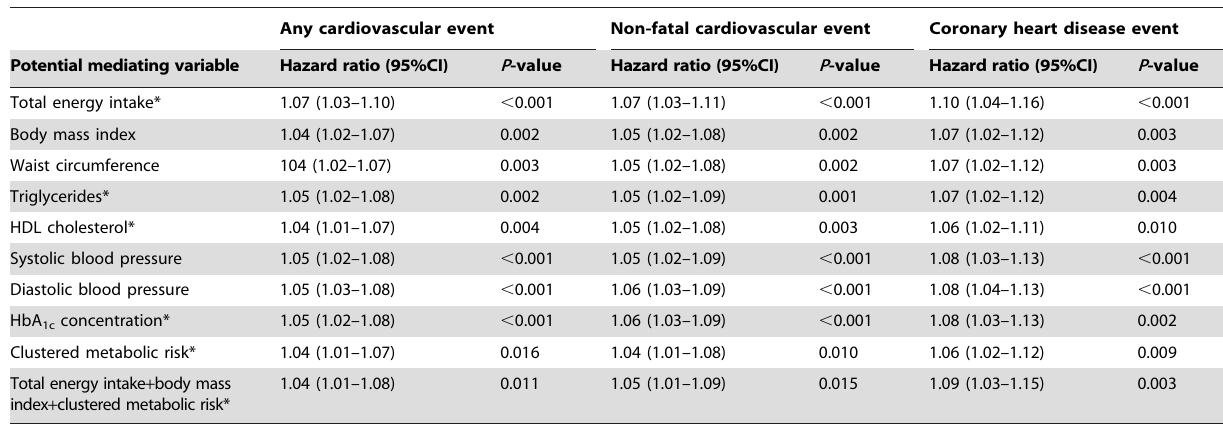
Table 5. Hazard ratios (95%CI) for any cardiovascular, non-fatal cardiovascular and coronary heart disease events per hour/day increase in television viewing in 12,608 men and women in EPIC Norfolk, 1998–2007, after additional adjustment for potential mediating